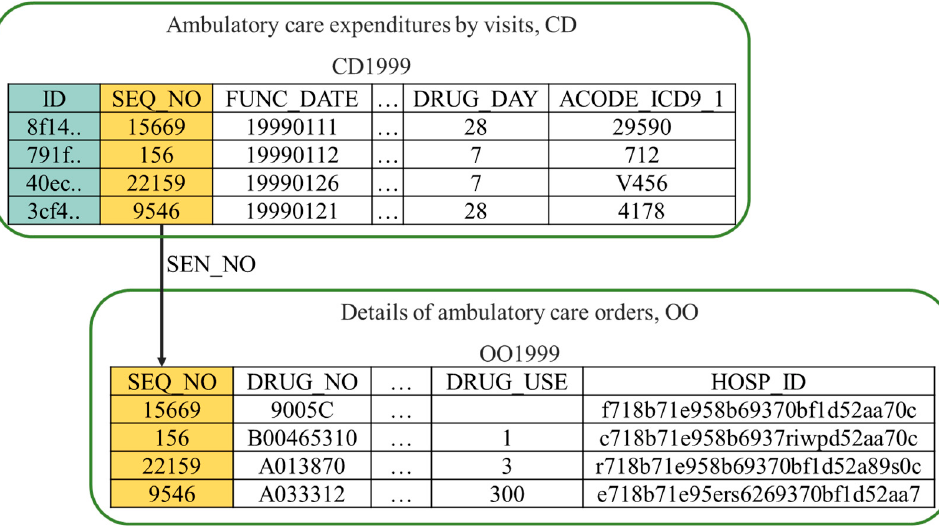
Figure 3. Data preprocessing flow chart.